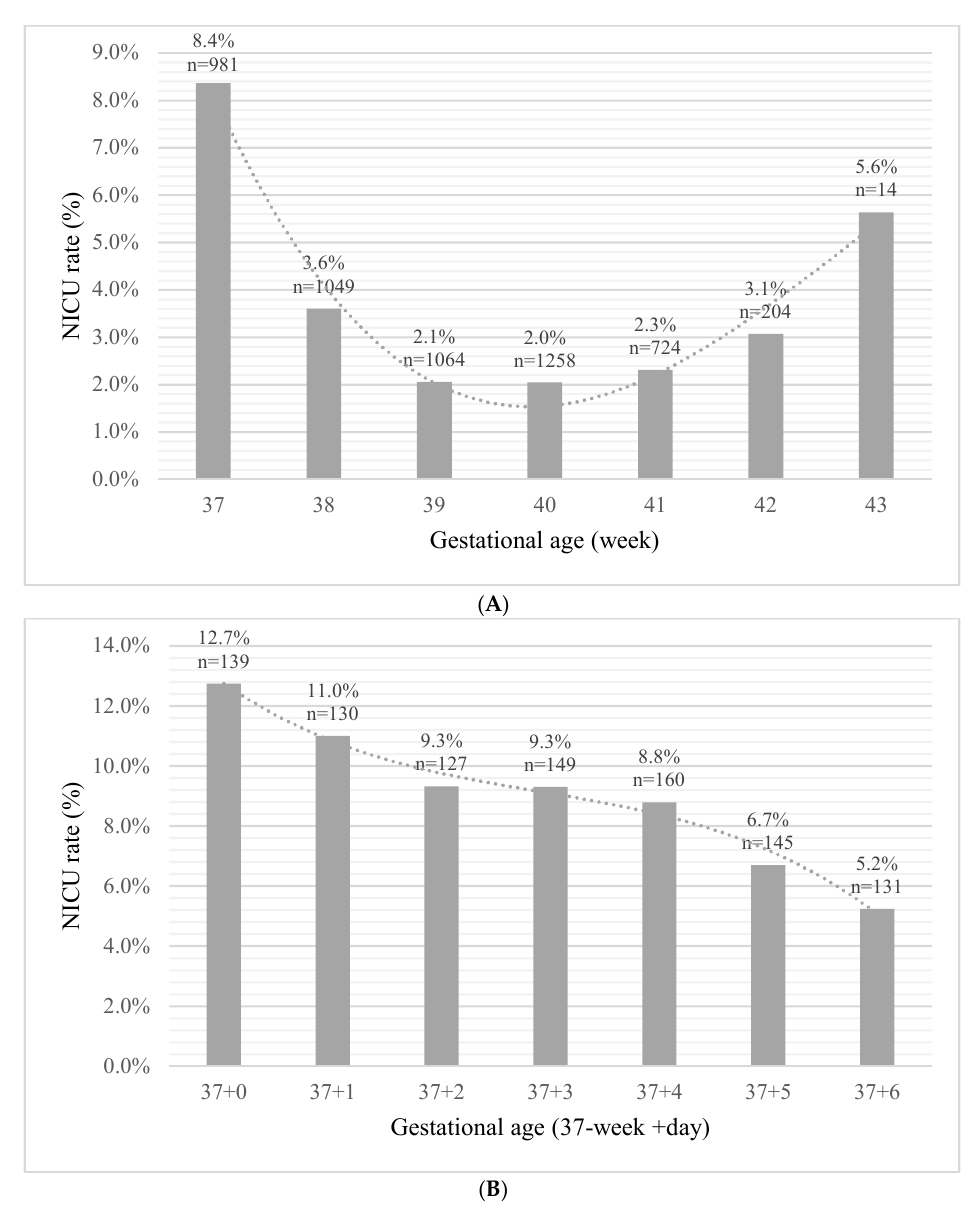
Figure 2. ( A ): NICU admission rate by week of gestation at birth. ( B ): NICU admission rate within the 37th week.